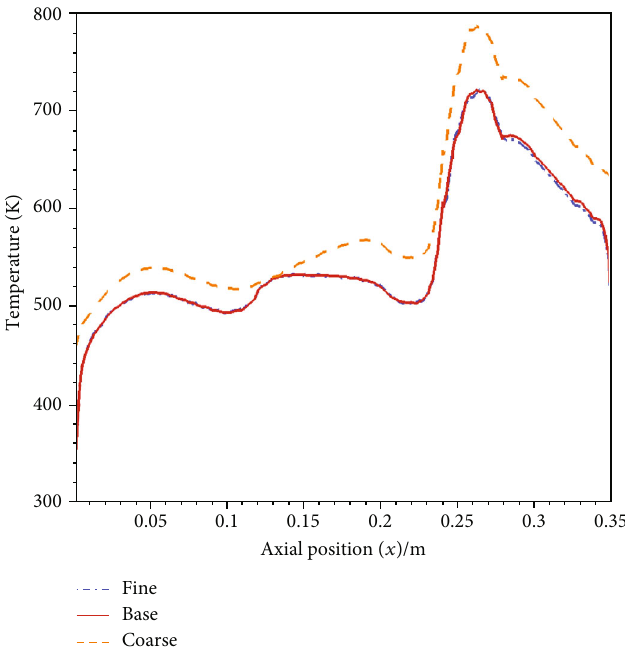
Figure 4: The numerical result of temperature distribution and streamlines.